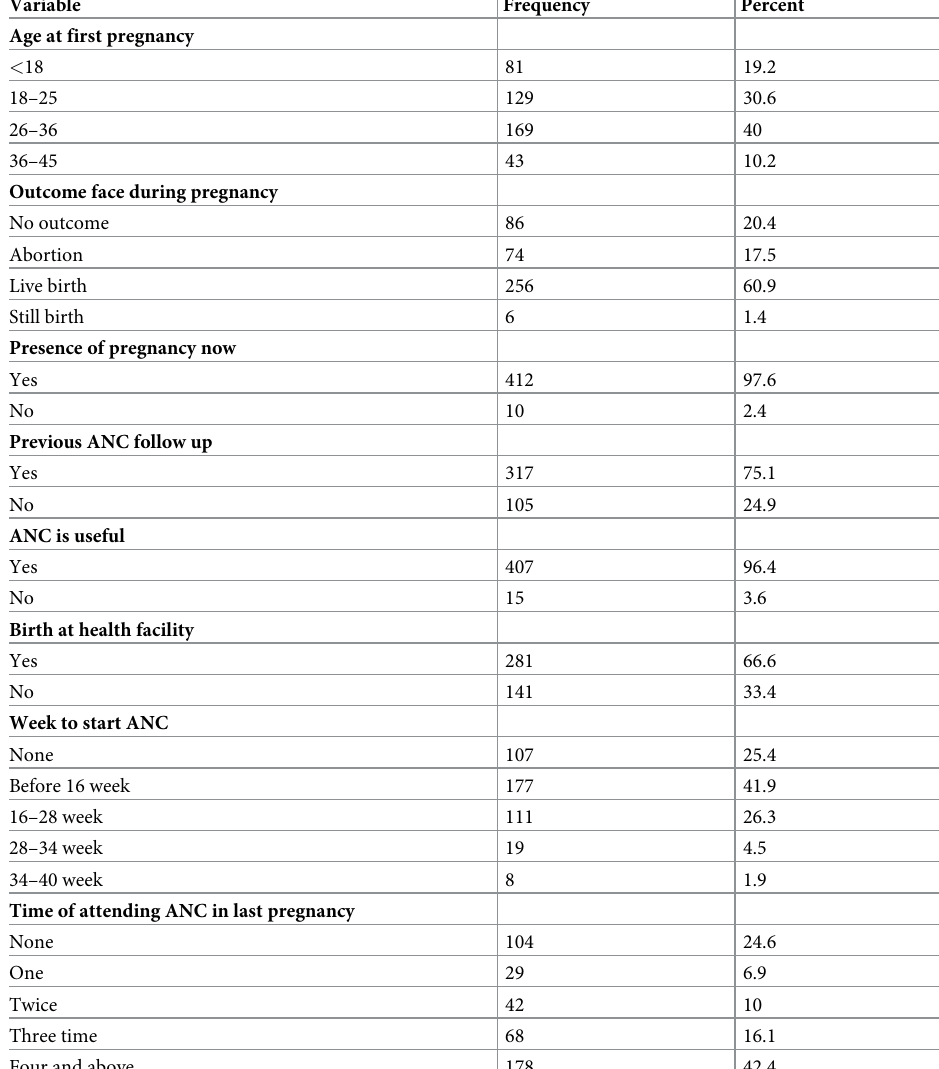
Table 2. Obstetrics characteristics of women attending ANC follow up in Yirgalem general Hospital, Sidama Zone, Ethiopia; 2019 (n =